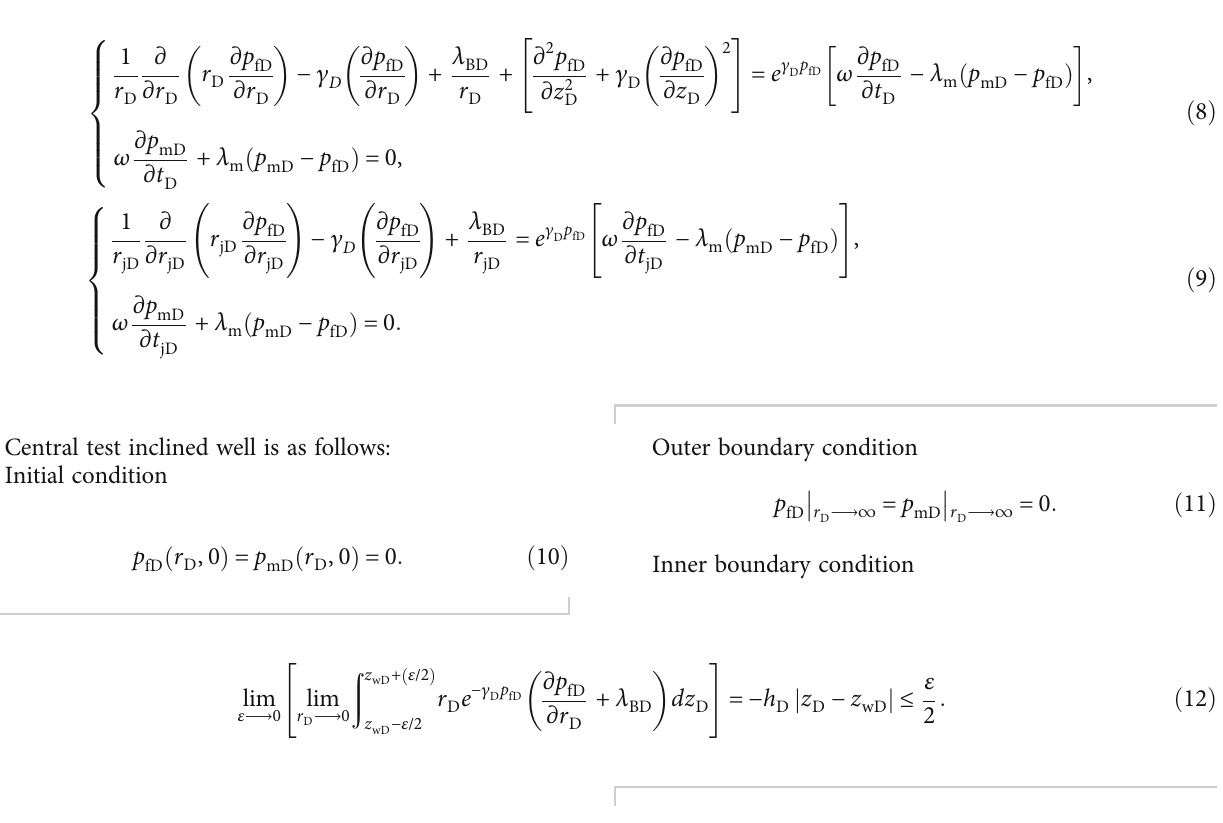
Substituting the above dimensionless quantities into for- mulas (5) and (6), the dimensionless seepage di ff erential equation is obtained: